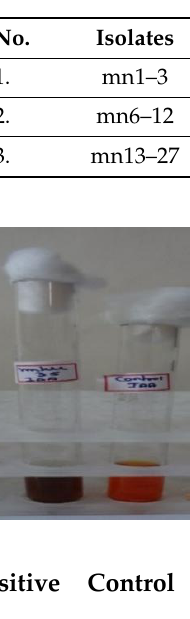
Figure 1. Indole acetic acid